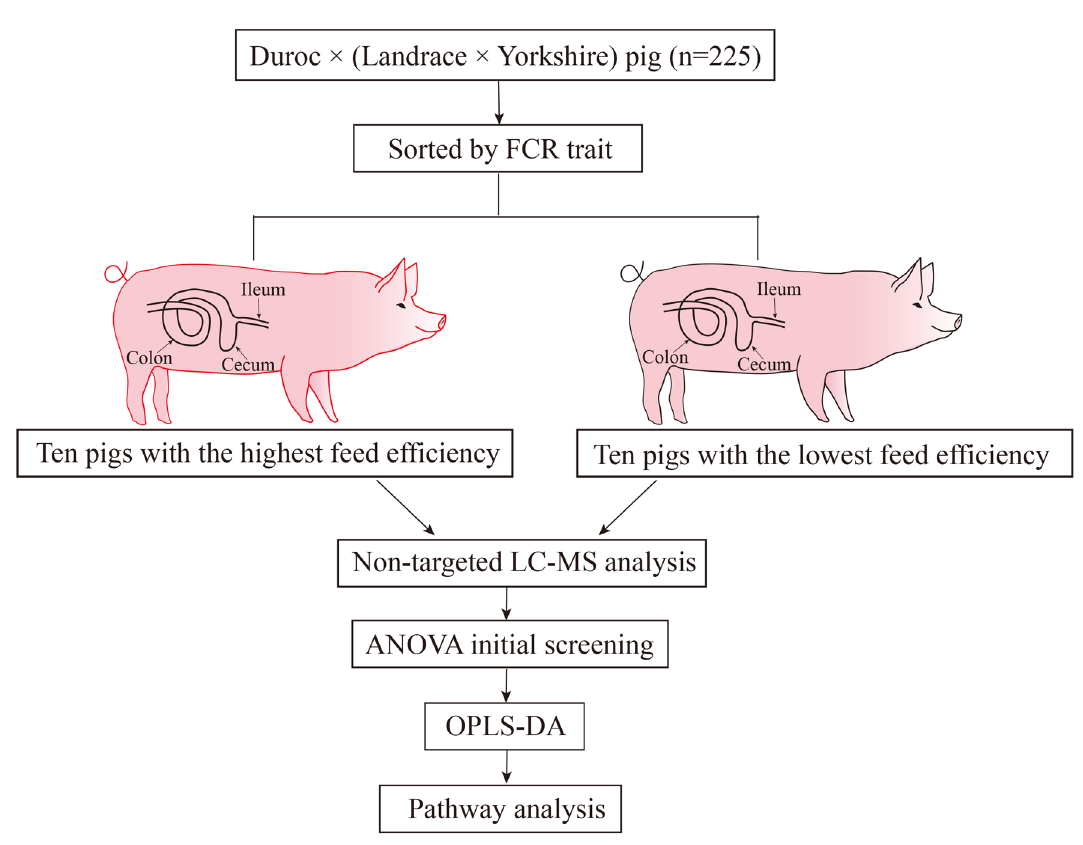
Figure 1. Overview of the experimental